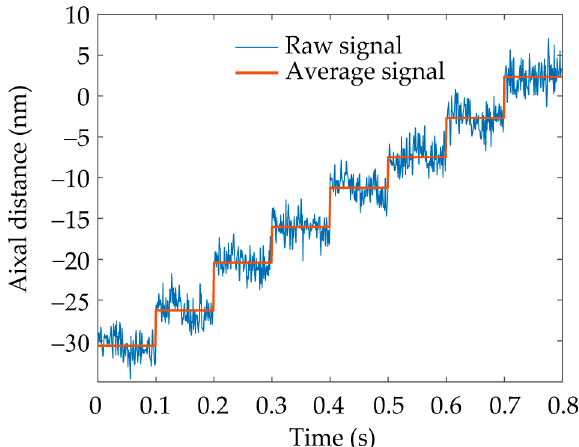
Figure 3. Test of the detection sensitivity at an axial step interval of 5 nm on the coverslip. The axial distances between the substrate and the objective lens were measured 100 times and averaged at each axial position of the substrate in 0.1 s.